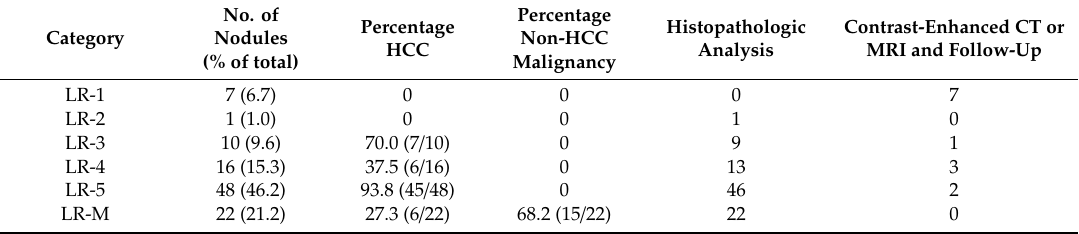
Table 3. Percentages of hepatocellular carcinoma (HCC) and non-HCC malignancies in each modified CEUS LI-RADS category.